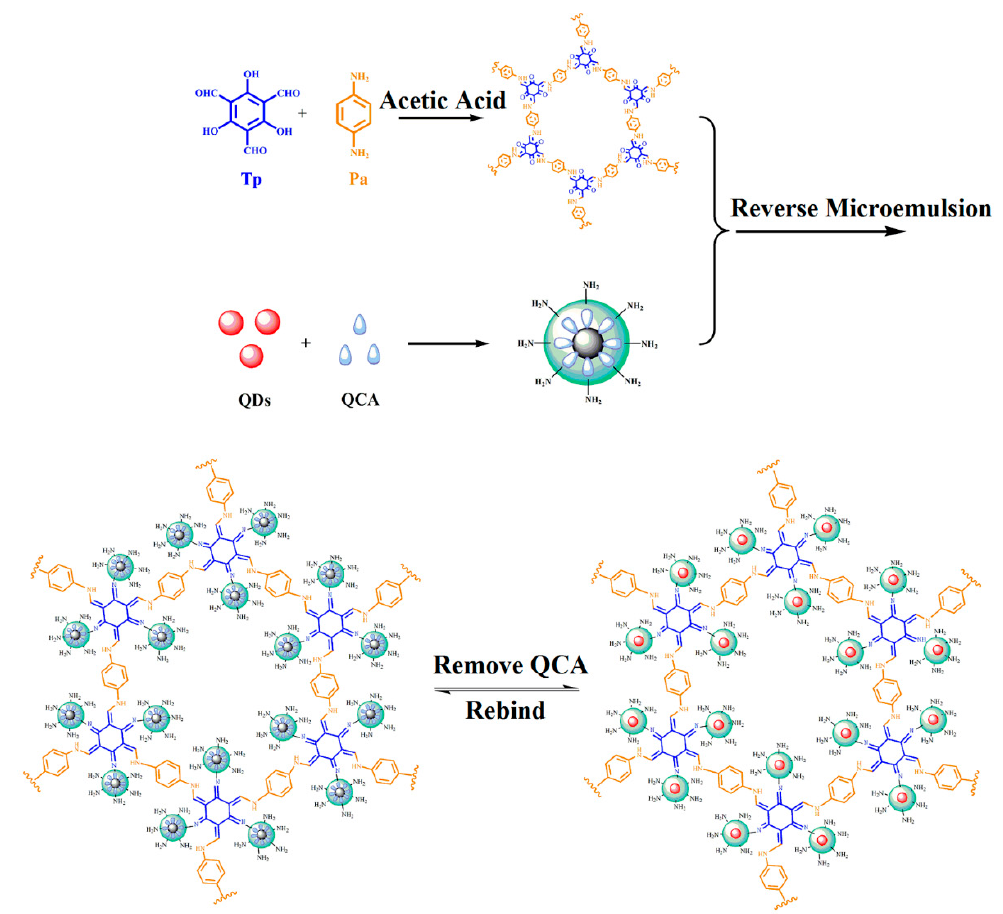
Figure 1. Scheme for the preparation of quantum dots (QDs)-grafted covalent organic frameworks